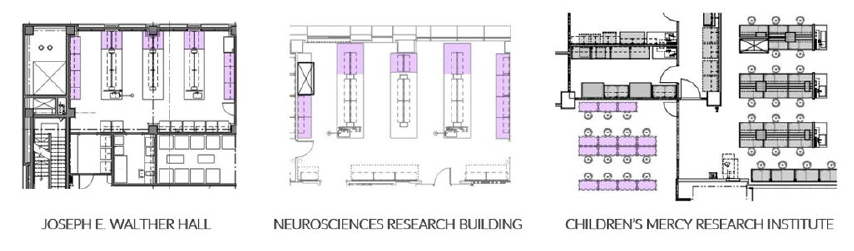
Figure 14 An example of lab workstations transitioning outside the laboratory environment within a typical floor plan.